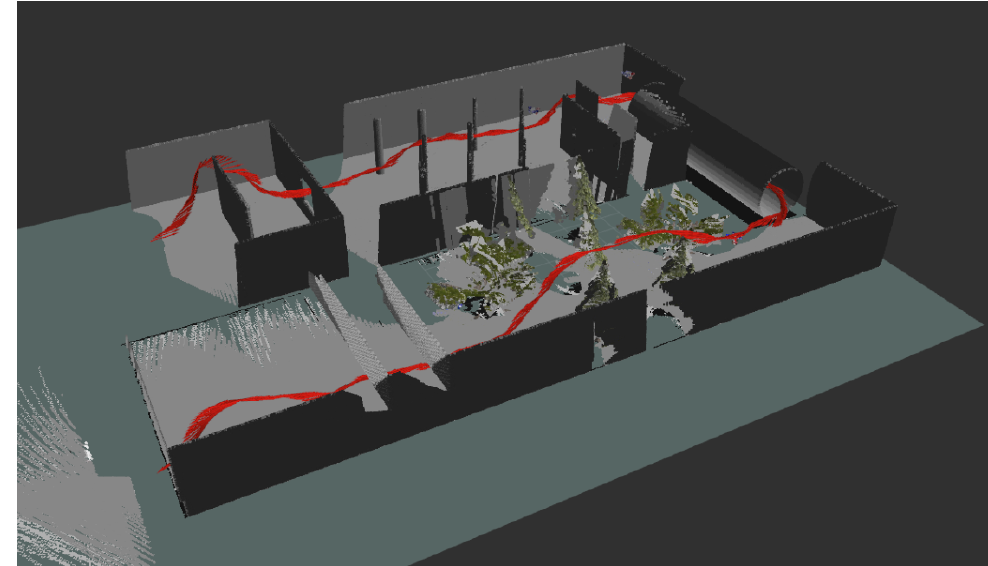
Figure 23. Visualization of the trajectory of UAV controlled by the SCAN algorithm (Area 1, Area 2, and Area 3) in rviz, 3D